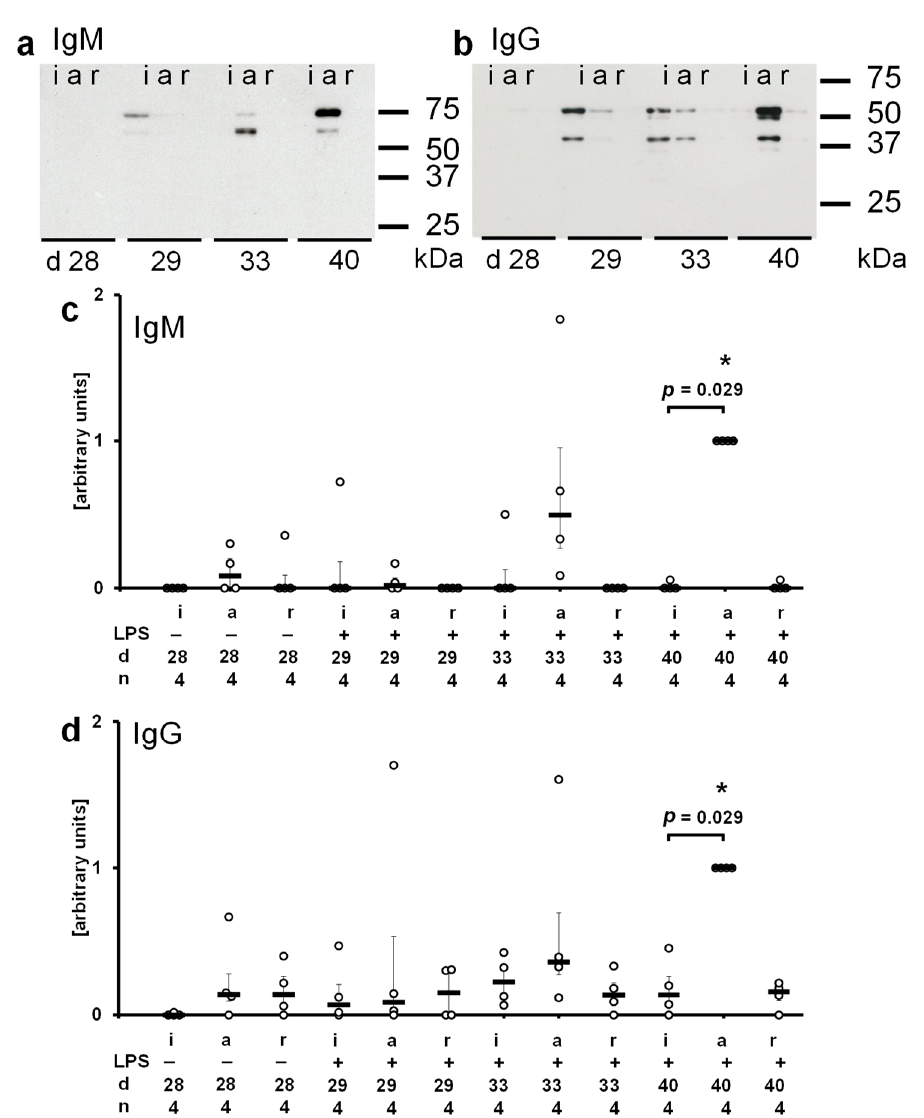
Figure 4. Accumulation of immunoglobulin (Ig) M and IgG in lung tissue. Protein extracts of pulmonary isografts, allografts, and right native lungs of allograft recipients (i, a, r) were separated on SDS polyacrylamide gels (10%) along with molecular mass standards. Proteins were blotted and probed with antibodies directed to rat IgM or rat IgG. Postoperative day 28 (d 28) before intratracheal instillation of lipopolysaccharide (LPS) as well as on postoperative days 29 (d 29), 33 (d 33), and 40 (d 40), 1, 5, and 12 days after treatment with LPS, respectively, were investigated. Representative Western blots for IgM ( a ) and IgG ( b ) are depicted ( n = 4 each). A semiquantitative, densitometric analysis was performed and the results are depicted for IgM and IgG in ( c ) and ( d ), respectively. Data are presented as individual data points, bar represents median, whiskers encompass the 25th to 75th percentile. Explorative data analysis was performed using Kruskal–Wallis test fol- lowed by Mann–Whitney U-test; * p ≤ 0.05, different from d 28 allografts.